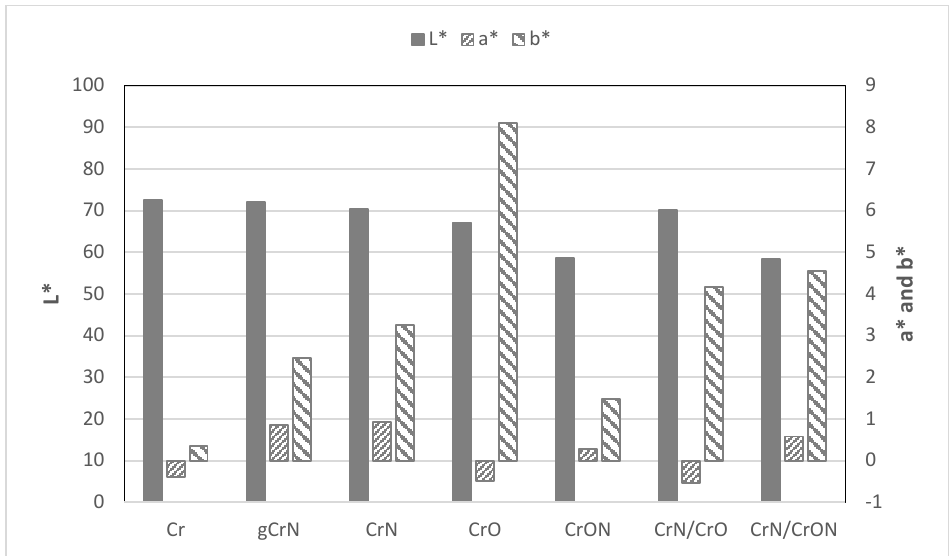
Figure 1. CIELAB color coordinates of the sputtered coatings onto PC substrates.